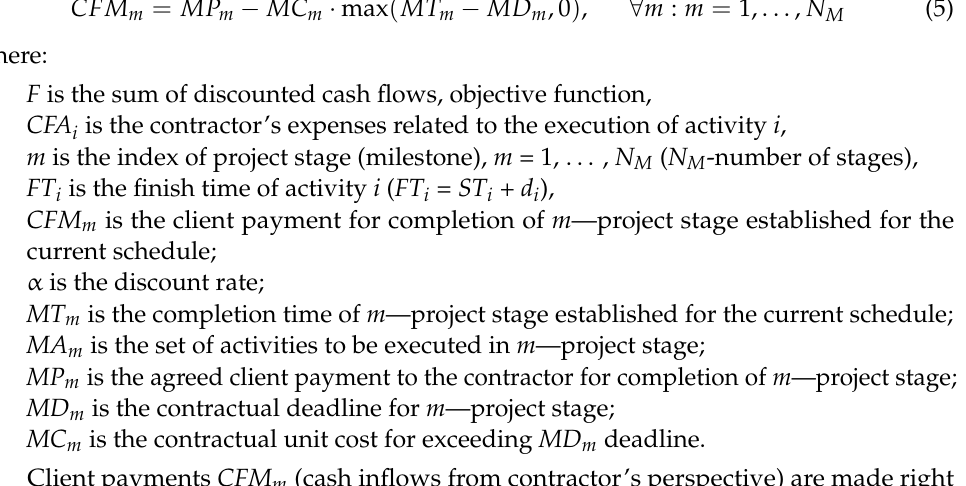
Figure 2. Baseline schedule. Assume that based on the baseline schedule of Figure 2 three contractual stages of work that are distinguished that have the following completion times: MD 1 = 4, MD 2 = 8, MD 3 = 12. Activity sets to be completed in further stages are as follows MA 1 = {1, 2}, MA 2 = {3, 4, 5}, MA 3 = {6, 7, 8}. The cash flow related to CFA i activities and the data for stage project settlements such as: contractual completion times MD m , client contractual payment amounts MP m and delay costs MC m , are shown in the AON representation in Figure 3. Milestone data is denoted by the “square” symbol. The same colours show the nodes representing activities from the same stage of the project. The stage settlements should be arranged to encourage the contractor to execute the project as quickly as possible and not to exceed MD m completion times.